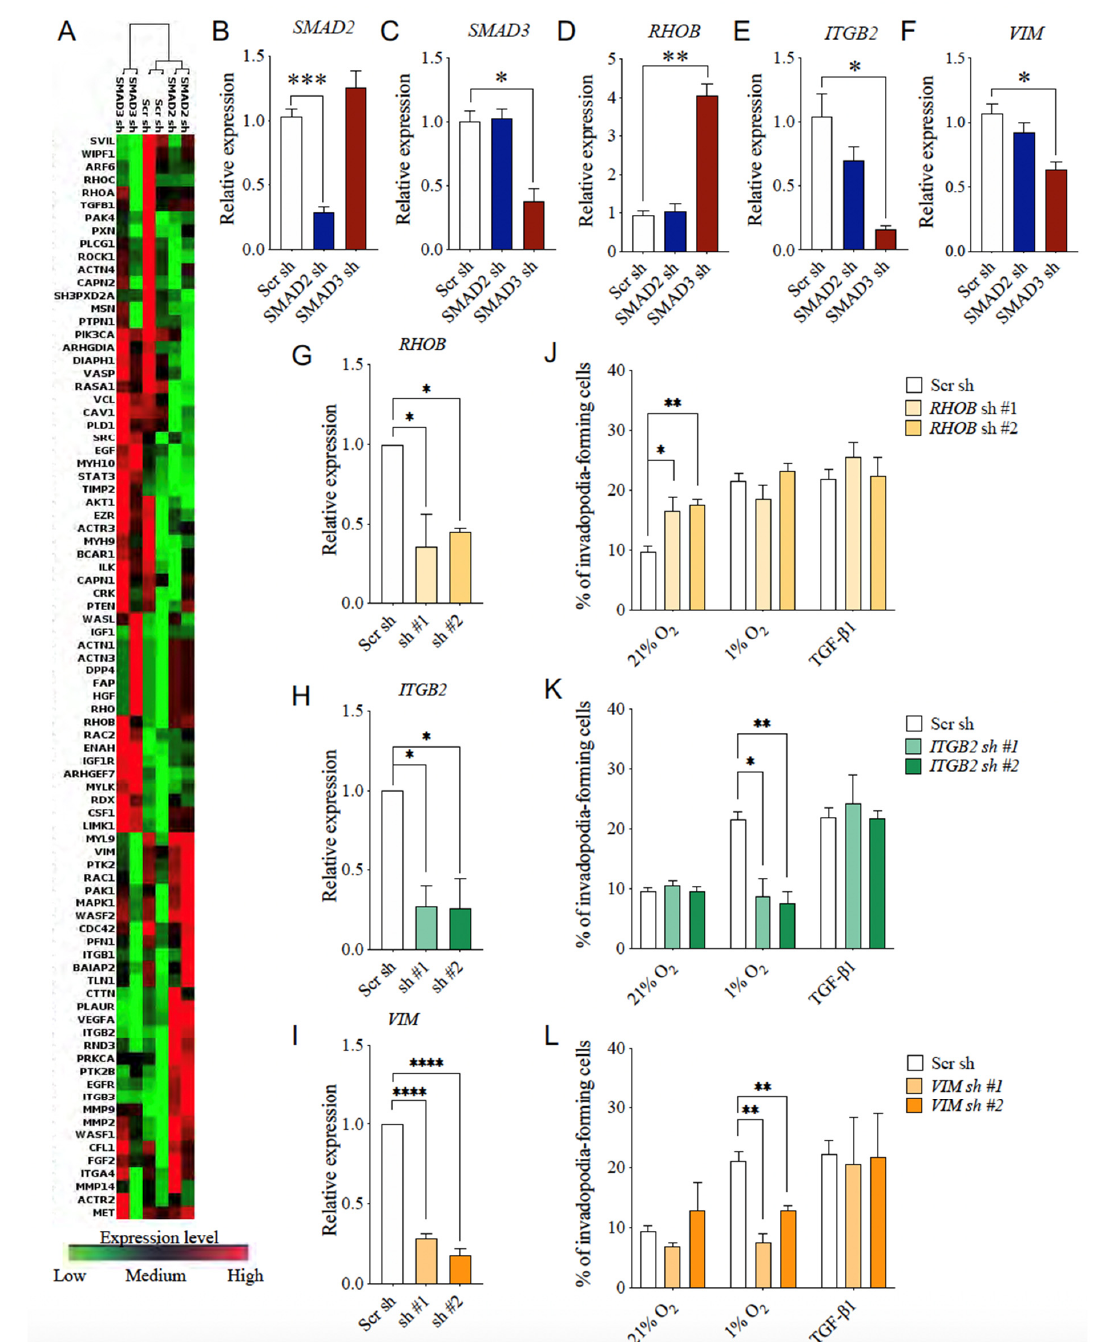
Figure 8. SMAD3 Target Genes Implication in Invadopodia Production by Cancer Cells. ( A ) Clus- tergram generated by RT 2 PCR array data analysis software showing expression level of 84 cell invasion-related genes. ( B – F ) Bar graph showing relative expression of SMAD2 ( B ), SMAD3 ( C ) and SMAD3 target genes RHOB ( D ), ITGB2 ( E ), VIM ( F ) in HT-1080 cells transduced with SMAD2- or SMAD3-targeted shRNAs ( n = 3). ( G – L ) HT-1080 cells were transduced with shRNAs targeting the individual SMAD3 invasion-related genes RHOB , ITGB2 and VIM , and submitted to invadopodia assays under normoxic (21% O 2 ), hypoxic (1% O 2 ), or TGF β 1-supplemented conditions. Relative expression ( G – I ) and percentage of invadopodia-forming cells ( J – L ) following each gene depletion are presented ( n = 3–6). Data are presented as mean ± SEM. * p < 0.05; ** p < 0.01; *** p < 0.001; **** p <